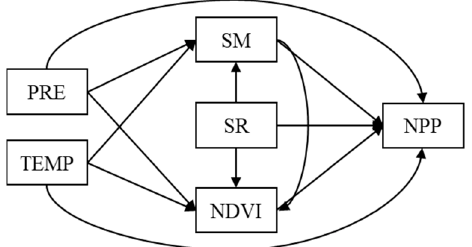
Figure 2. Conceptual structural equation mode. Note: Arrows between variables to NPP identified the cause and effect relations. Note: precipitation (PRE), temperature (TEMP), soil moisture (SM), and solar radiation (SR).